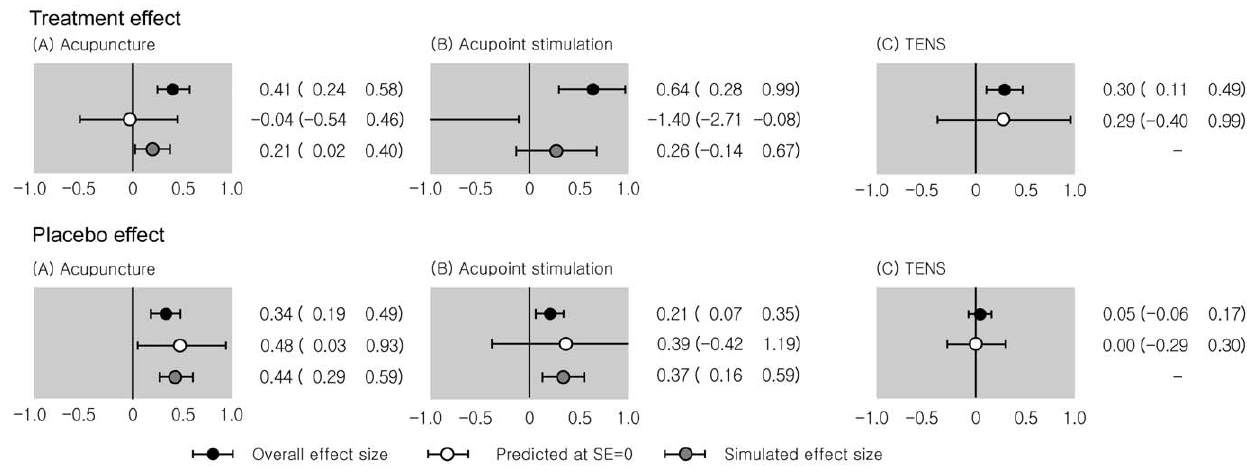
Figure 4. Results of effect sizes combined over all trials, effect sizes predicted for trials from random effects meta-regression analysis with standard error =0, and effect sizes simulated on data from nonparametric trim and fill analysis. SE = standard